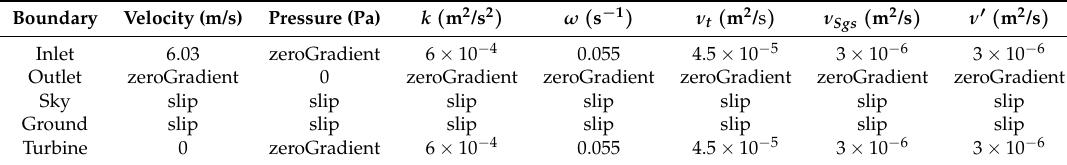
Table 1. Main boundary